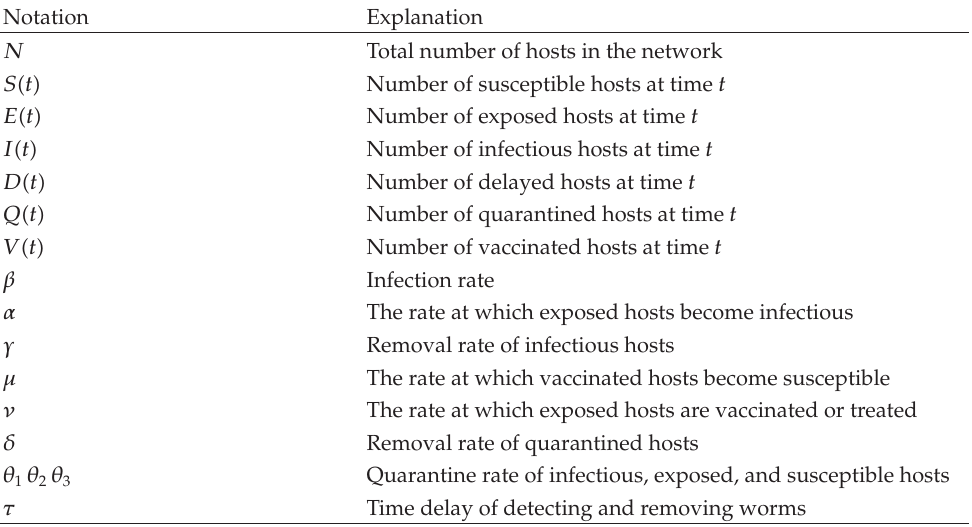
Table 1: Notations in this paper.